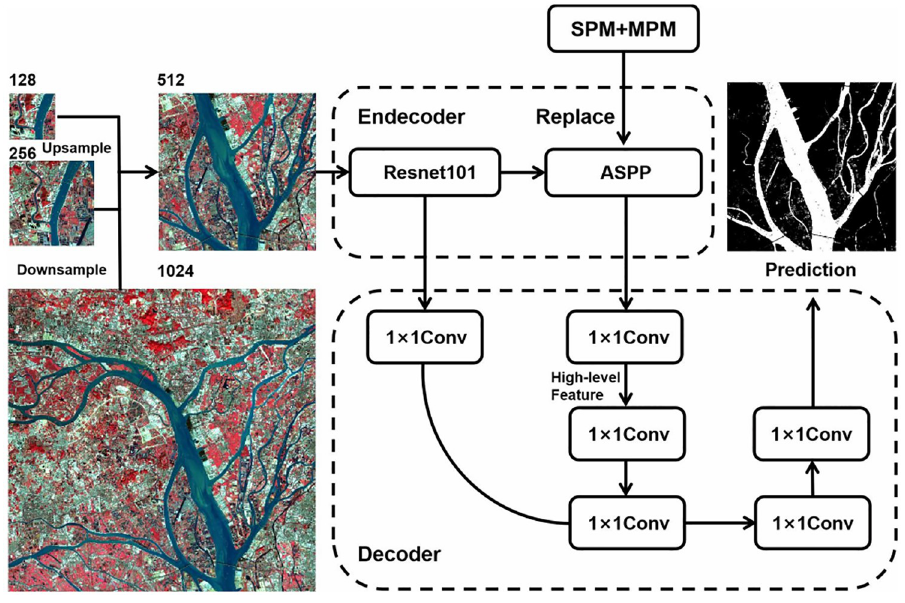
Fig 9. Replacing the ASPP module with the SPM and MPM modules. Reprinted from www.gscloud.cn under a CC BY license, with permission from Dr. Qinghui Lin, original copyright 2019.